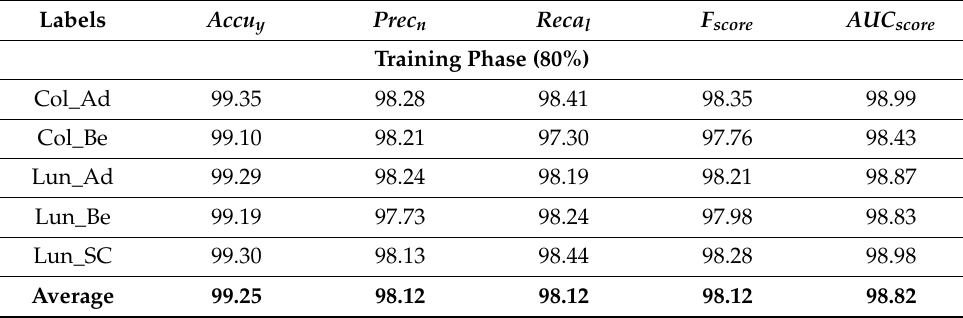
Table 2. Classifier outcomes of MPADL-LC3 approach on TRS/TSS of 80:20.